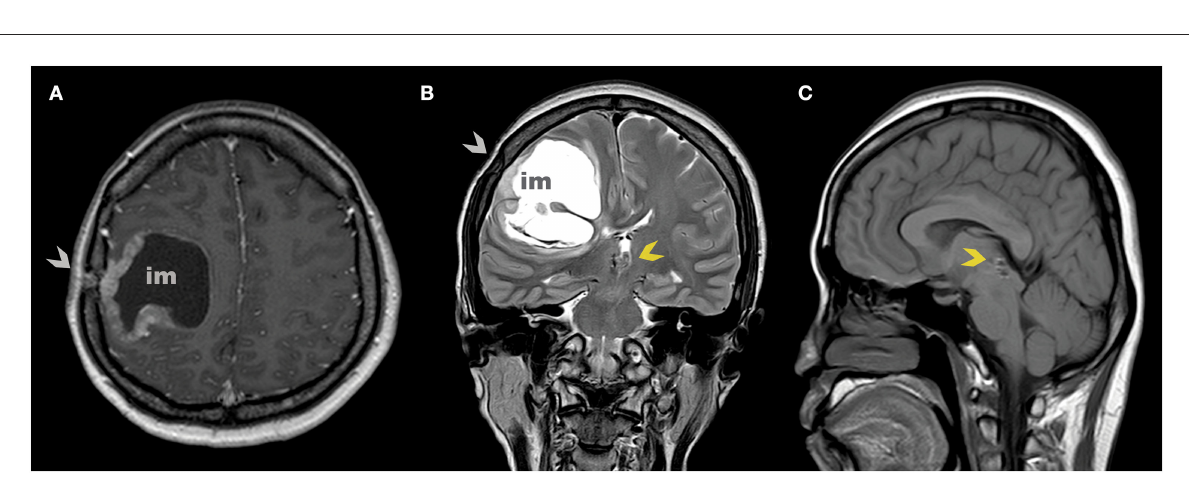
FIGURE2 Axial (A) and coronal (B) MR scan at 7 years after the initial diagnosis show implantation metastasis under burr hole post stereotactic biopsy (gray arrowhead). Sagittal (C) MR scan shows no tumor on the pineal region (yellow